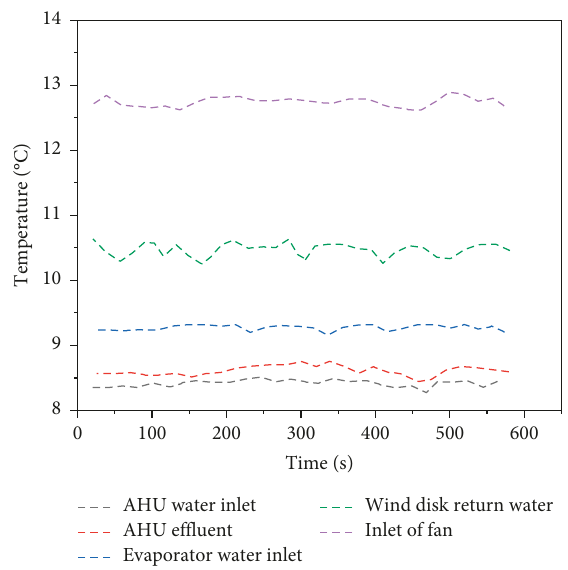
Figure 9: Stability test of chilled water